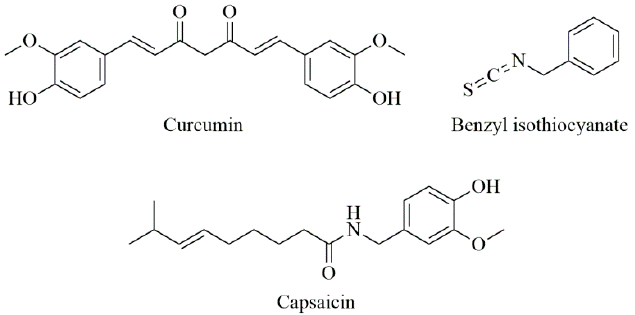
Figure 3. Chemical structures of curcumin, benzyl isothiocyanate, and capsaicin.